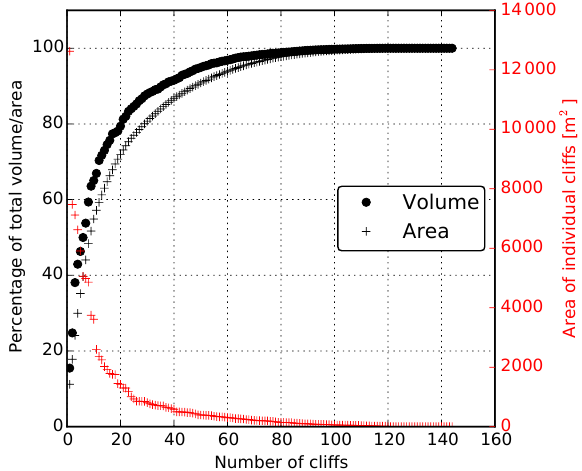
Figure 8. Individual ice cliff contributions for the period Novem- ber 2015–November 2016 based on the UAV data. The left axis shows the cumulative volume (black dots) and area (black crosses), expressed as a percentage of the total volume or area. The right axis shows the area of individual cliffs (red